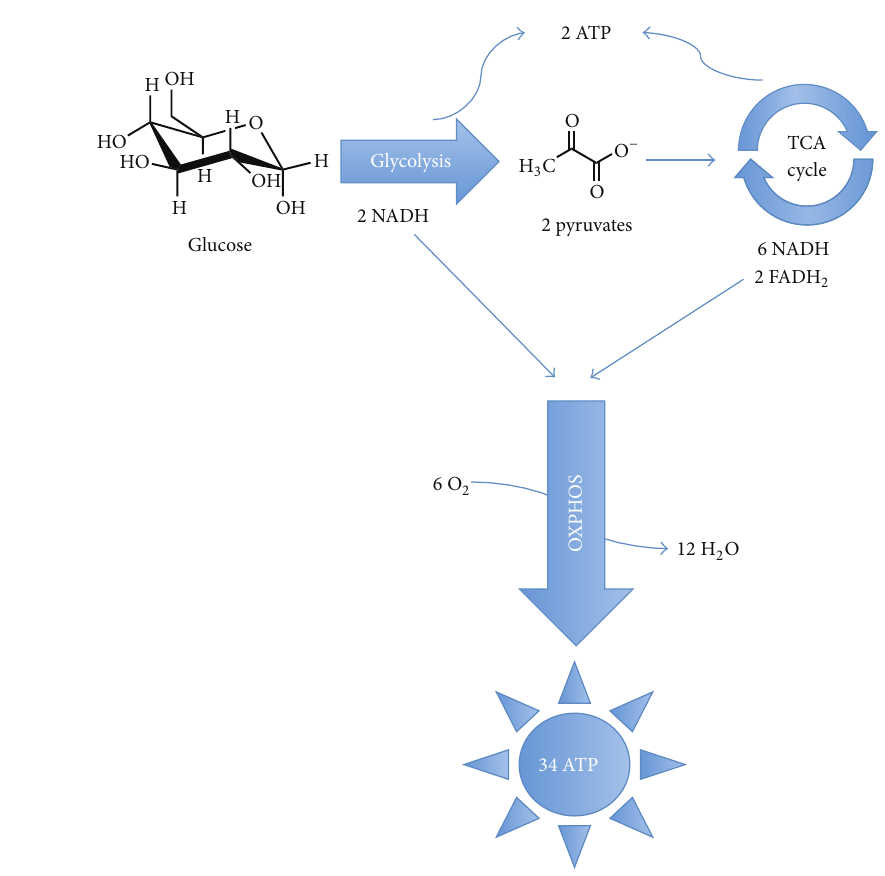
Figure 1: Overview of ATP production in eukaryotic cells. Complete oxidation of glucose to water and carbon dioxide occurs in three processes: glycolysis, the TCA cycle, and oxidative phosphorylation